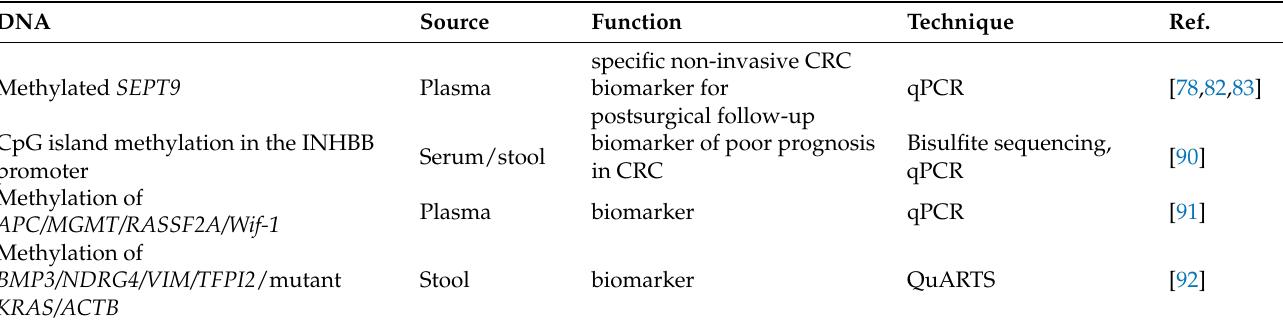
Table 3. List of methylated cfDNA biomarkers in